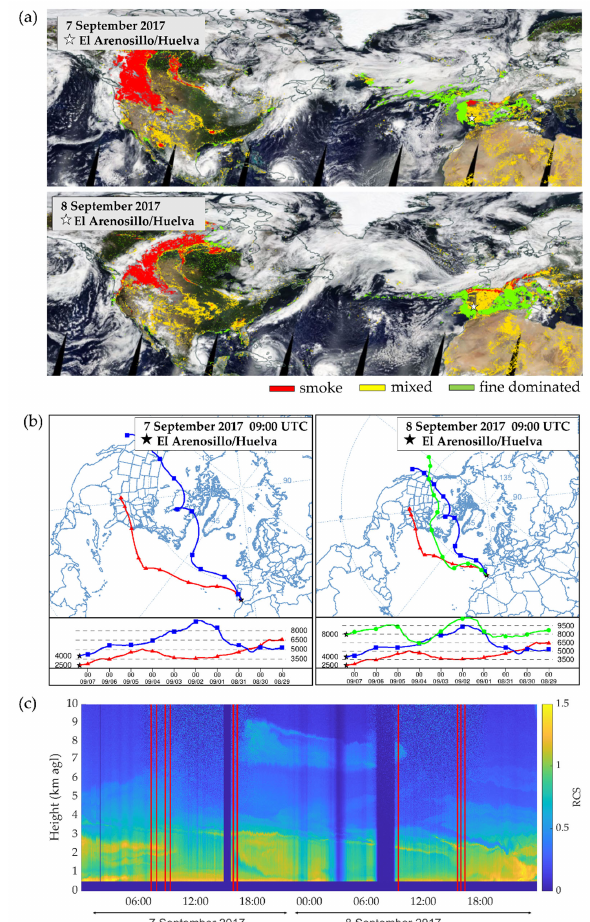
Figure 1. ( a ) Deep Blue Aerosol Type (Suomi NPP/VIIRS) and corrected reflectance (TERRA/MODIS) on 7 and 8 September 2017. The ARN station is marked with a white star. ( b ) HYSPLIT 10 ‐ day backward trajectories arriving at ARN/Huelva (Spain; marked with a black star) at altitudes of (left) 2500 (red) and 4000 (blue) m a.g.l., and (right) 2500 (red), 4000 (blue) and 8000 (green) m a.g.l. on 7 and 8 September 2017, respectively. ( c ) Lidar range ‐ corrected signal (RCS) at 532 nm for the period of 7 September 2017 at 00:00 UTC to 9 September 2017 at 00:00 UTC at ARN. Vertical red lines indicate the periods with correlative sun/sky radiances that allow for GRASP